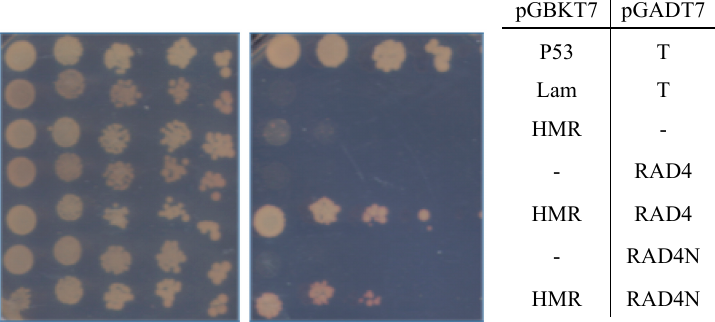
Figure 3. Yeast two-hybrid analysis of the interaction between the RAD4 N-terminus and RAD23B. The RAD4 N-terminal half is sufficient to interact with RAD23B. Five-fold dilutions of the indicated diploid strains were plated on the double drop-out (–leu, –trp) control plate on the left, and the quadruple drop-out (–leu, –trp, –ade, –his) selection medium on the right. The interaction between p53 and T, resulting in growth on the selective medium, is the positive control, whereas Lam and T, which do not interact, are the negative control.